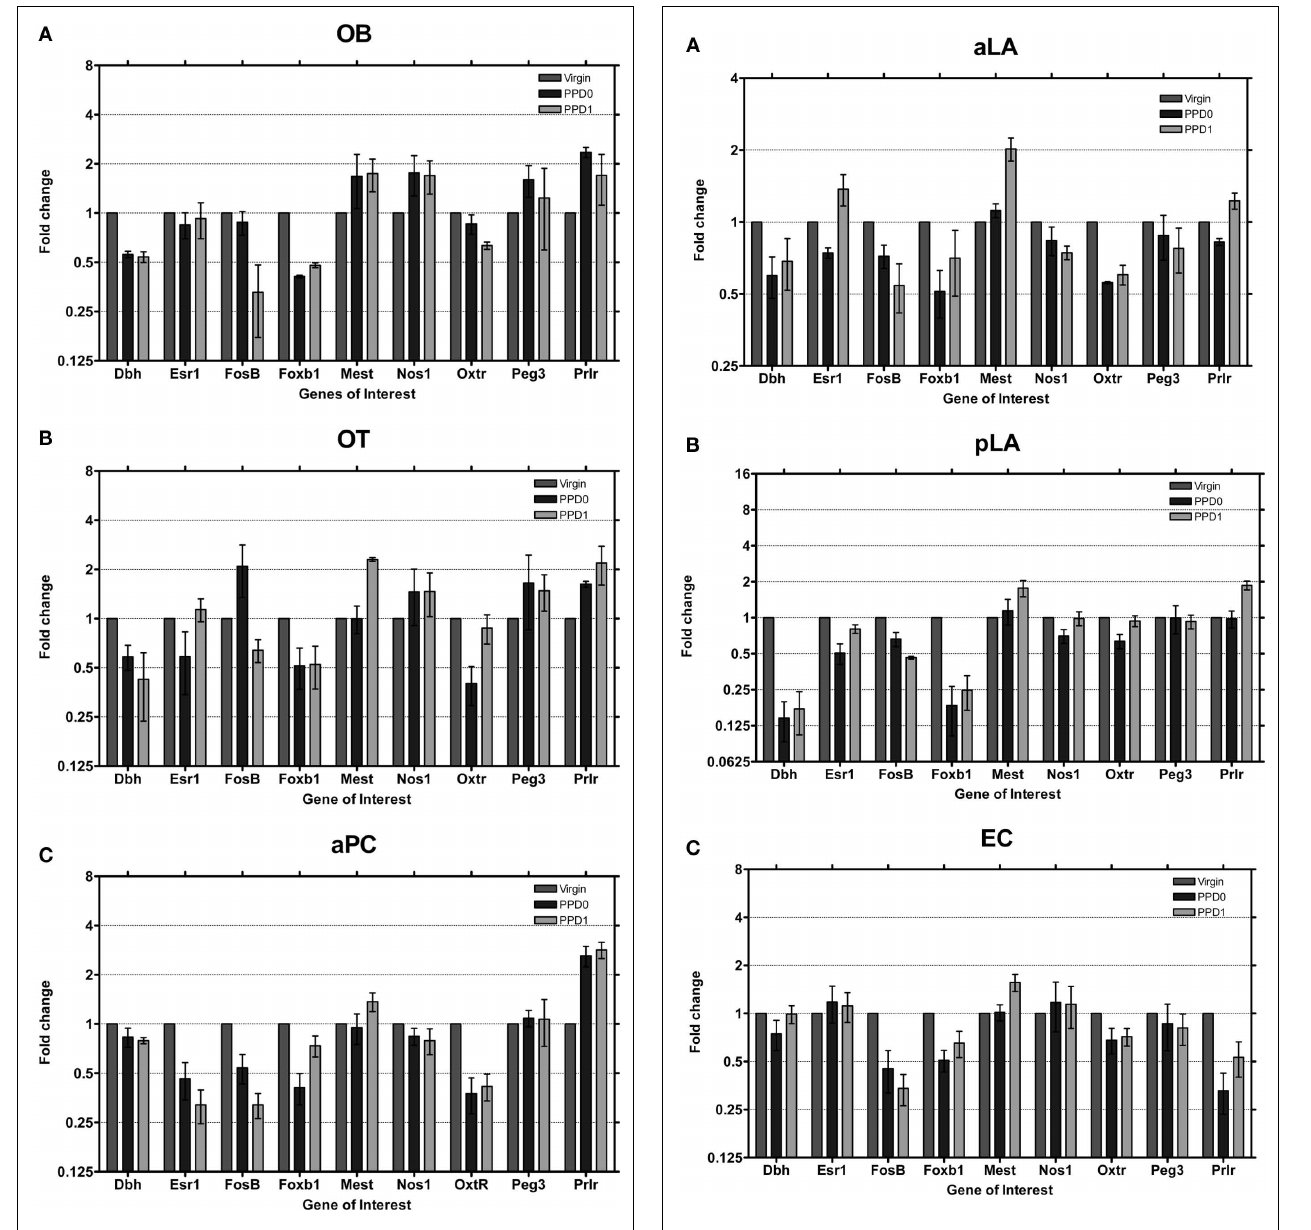
FIGURE 3 | Changes in fold expression (determined by C T method) at PPD0 and PPD1 in the (A) OB, (B) OT, and (C) aPC. Mean ± SD are plotted on a log2 scale, such that fold increases and decreases are represented linearly.